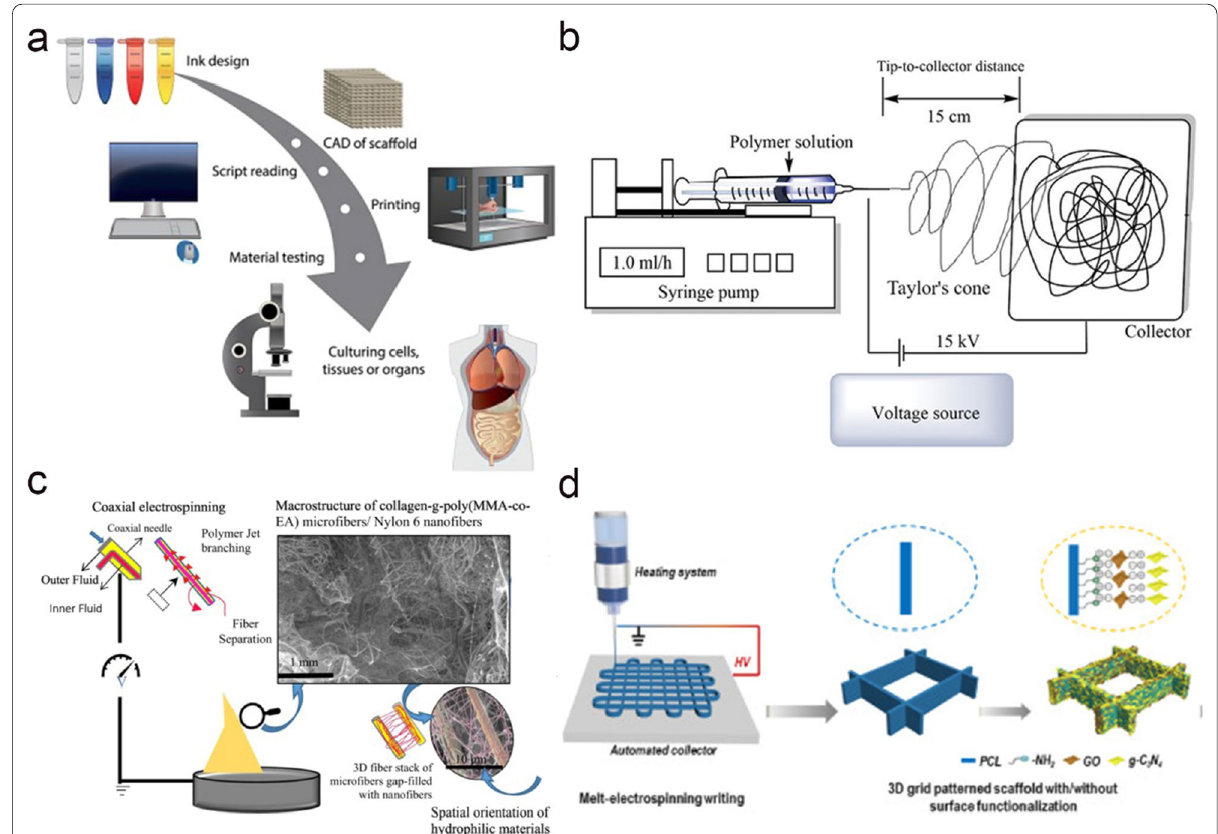
Fig. 5 Modern technology used in structured collagen. a Schematic diagram of the sequential steps involved in the printing process of a new material for tissue regeneration. Reproduced with permission from [94]; b Schematic of electrospinning technique of poly electrospun fibers. Reproduced with permission from [95]; c A block diagram of one-step fabrication of 3D fibrous collagen-based macrostructure with high water uptake capability by coaxial electrospinning. Reproduced with permission from [96]; d Scheme illustration of 3D polymeric grid patterned scaffolds decorated with visible-light photocatalyst as nerve guidance conduits (NGCs) for promoting peripheral neural regeneration. Reproduced with permission from